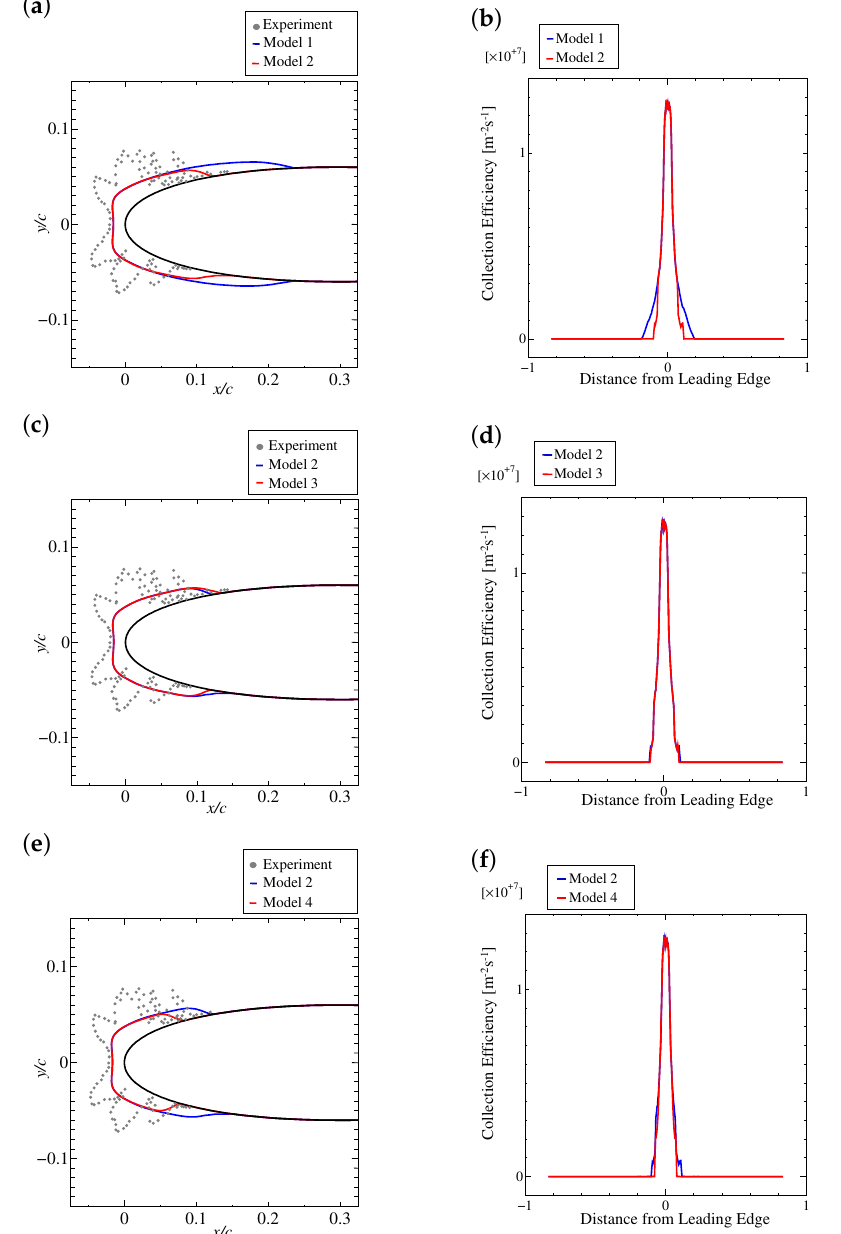
Figure 2. Comparison of ice shapes and collection efficiency for different SLD models: ( a , b ), Models 1 and 2; ( c , d ), Models 2 and 3; ( e , f ), Models 2 and